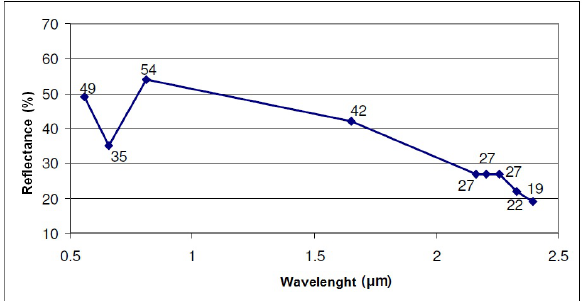
Figure 8. ASTER reflectance spectra to mining residues/basalt endmember